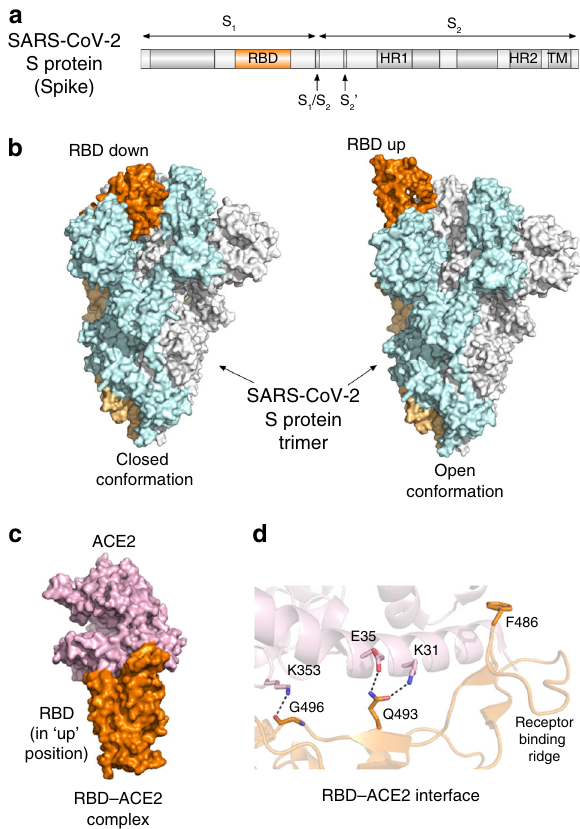
Fig. 1 Structural basis for the recognition of human ACE2 by the SARS- CoV-2 spike (S) protein. a Domain architecture of the SARS-CoV-2 spike protein. Receptor-binding domain (RBD), heptad repeats (HR1 and HR2), transmembrane domain (TP), and protease cleavage sites S 1 /S 2 and S 2 ′ are labeled. b Side views of the spike protein trimer in a closed conformation (left, PDB 6vxx) and open conformation (right, PDB 6vyb). Three protomers are colored light cyan, gray, and light orange. Buried in the closed state RBD (orange) from one of the protomers (light orange) swings up and is ready to bind ACE2 in the open state. c Side view of the RBD-ACE2 complex (PDB 6m0j). The RBD position is aligned to that of in ( b ). d Zoom in view of the interface of the RBD-ACE2 complex (PDB 6vw1). Dashed lines indicate salt bridges observed in the SARS-CoV-2 complex that are absent in the corresponding SARS-CoV